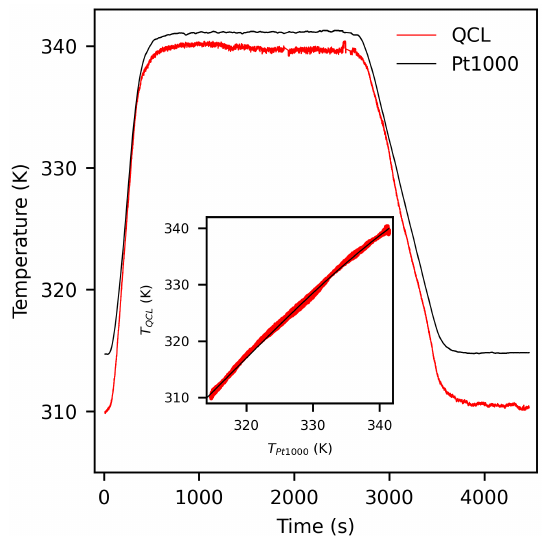
Figure 4. Temperature obtained from the QCL technique and the Pt1000 sensors during a heating cycle of the gas cell. Inset: Correlation between the temperature measured by the QCL technique and the Pt1000 sensors and quadratic fit (black